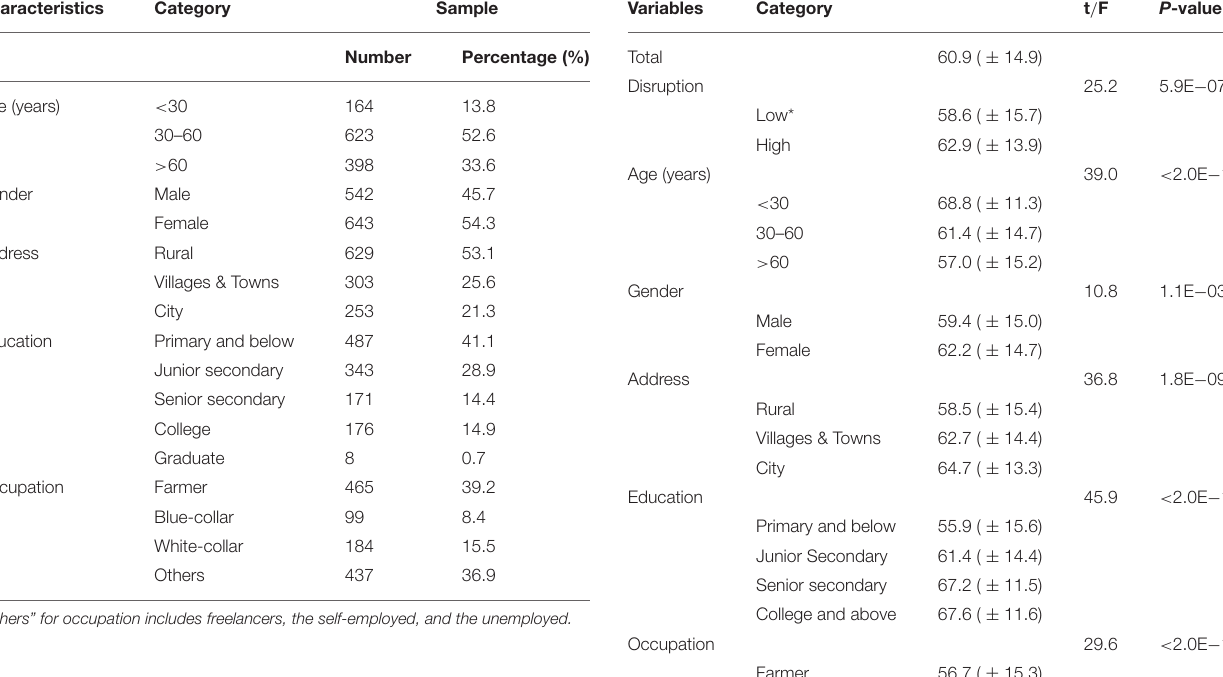
TABLE 1 | Baseline characteristics of the patients ( N = 1,185). Characteristics